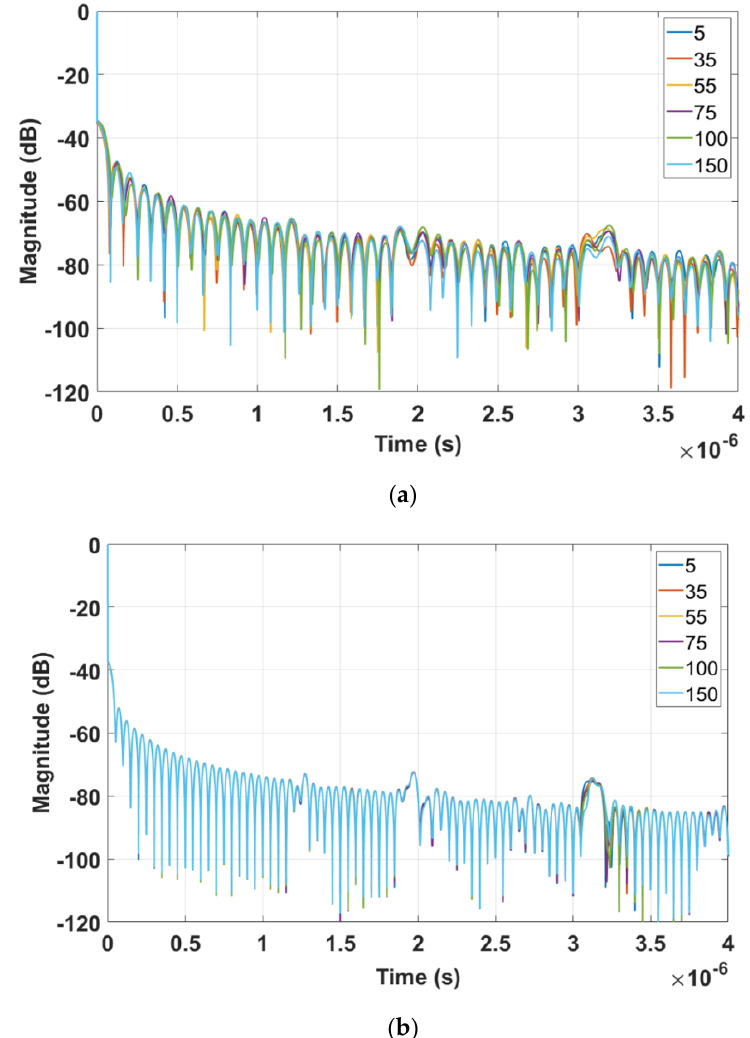
Figure 13. Magnitude of the time domain response after applying inverse Fourier transform to the frequency domain data: ( a ) measured by LimeSDR−mini and ( b ) measured by VNA.